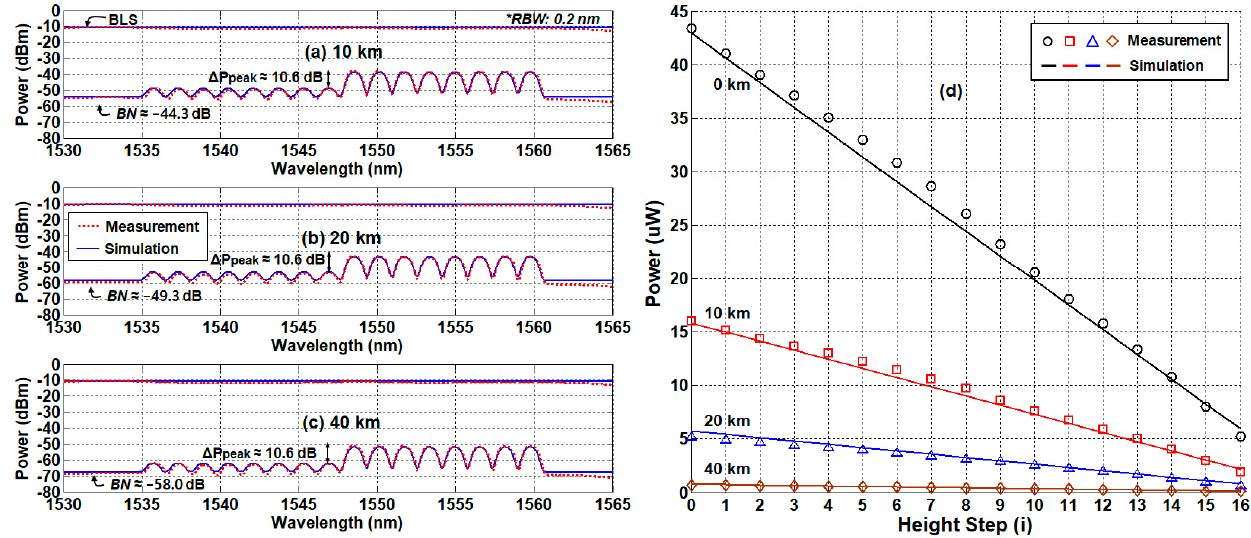
Figure 8. Measurement and simulation results at the different distances with dual-path network configuration. ( a ) The spectra of 1/2 water level at 10 km, ( b ) the spectra of 1/2 water level at 20 km, ( c ) the spectra of 1/2 water level at 40 km, and ( d ) optical-received power as a function of the water level with various fiber distances.